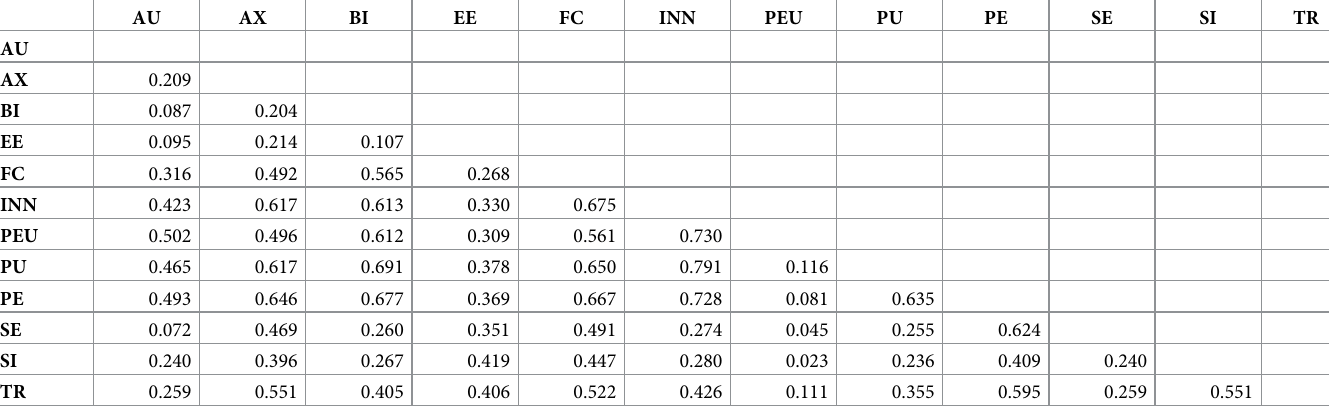
Table 5. Heterotrait-Monotrait ratio